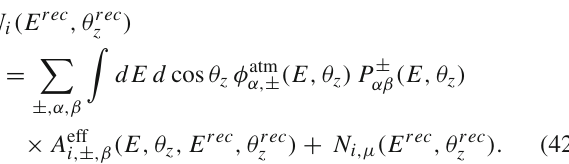
Fig. 4 Event distributions obtained for DeepCore in our numerical simulations as a function of the reconstructed values of the cosine of the zenith angle, for neutrinos in different reconstructed energy ranges. The lines have been obtained assuming a normal mass ordering, for the following values for the decoherence parameters: γ 21 = γ 31 =